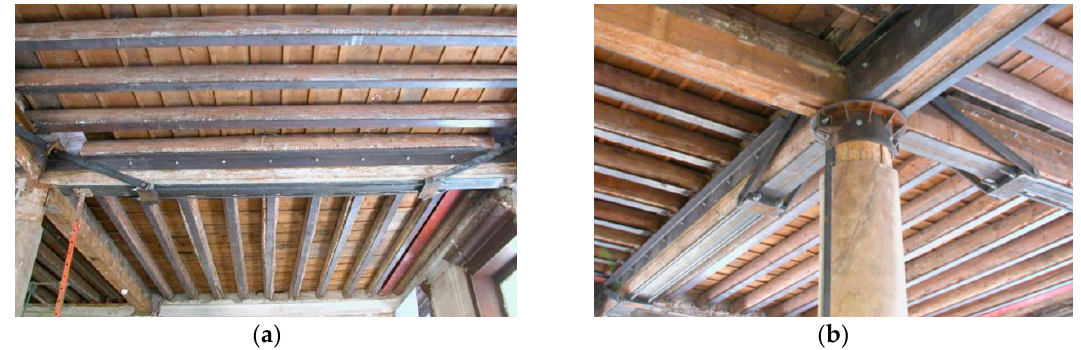
Figure 22. Steel plates and profiles as flexural reinforcement of timber beams [64].